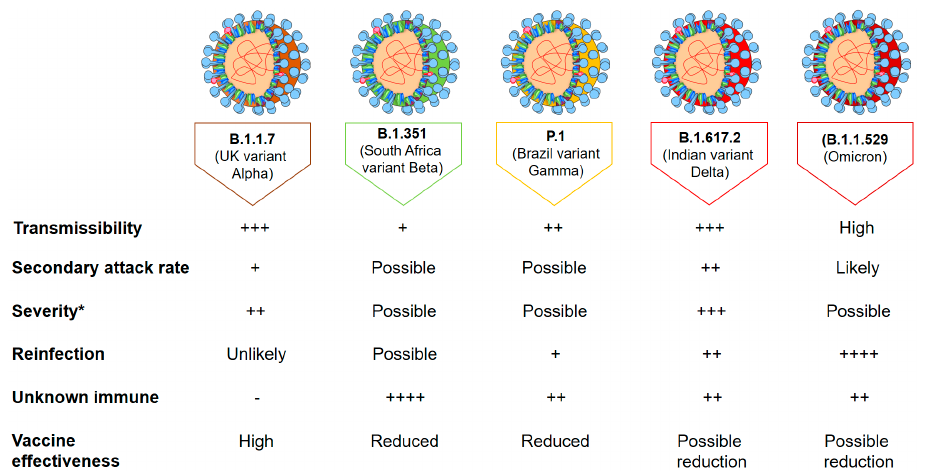
Figure 2. Properties of SARS-CoV-2 variants of concern. * Severity is determined by an increased risk of hospitalization and increased risk of mortality. The + . . . ++++ means the degree of disease severity, transmissibility